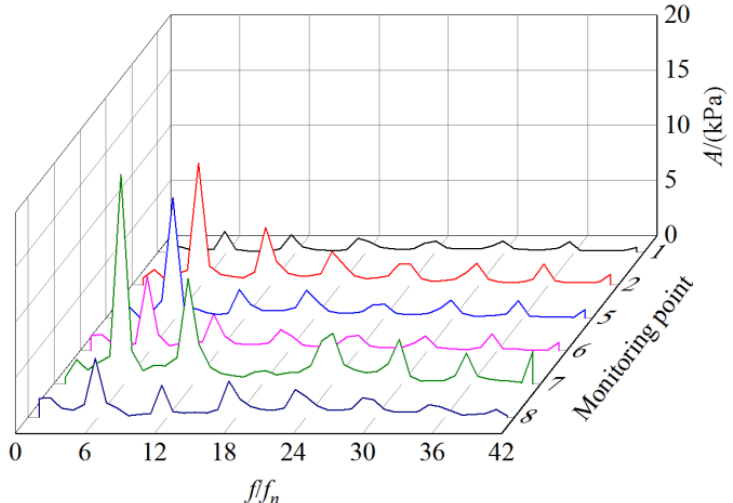
Figure 14. Frequency domain of pressure fluctuation at volute circumferential location (curves 1, 2 5, 6, 7 and 8 represent frequency domain curves at monitoring points1, 2, 5, 6, 7 and 8 respectively).